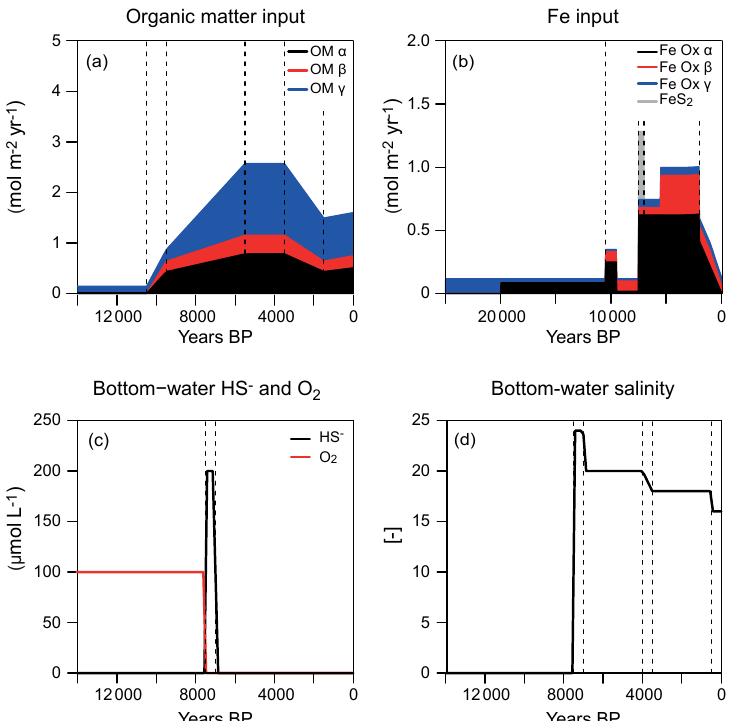
Figure 2. Model scenario of organic matter (OM) input (a) , Fe input (b) , bottom-water HS − and O 2 concentrations (c) , and bottom-water salinity (d) . Both Fe oxides and organic matter were divided into highly reactive ( α ), less reactive ( β ) and inert ( γ ) phases. Note the different timescale for panel (b) . Inputs and bottom-water concentrations were kept constant before the plotted time